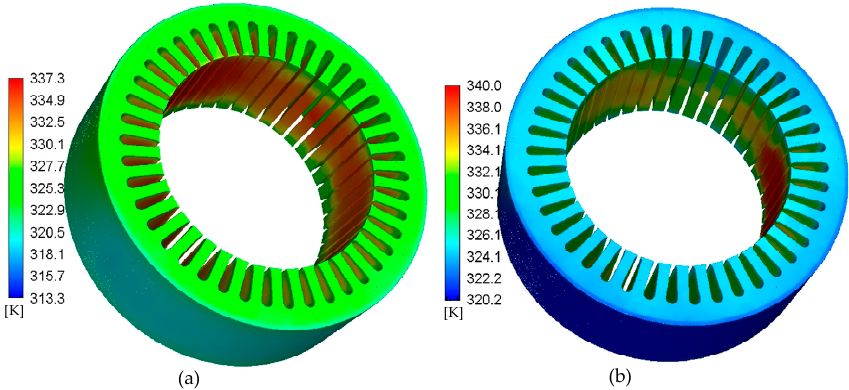
Figure 8. Stator temperature distribution. ( a ) Unidirectional coupling; ( b ) bidirectional coupling.